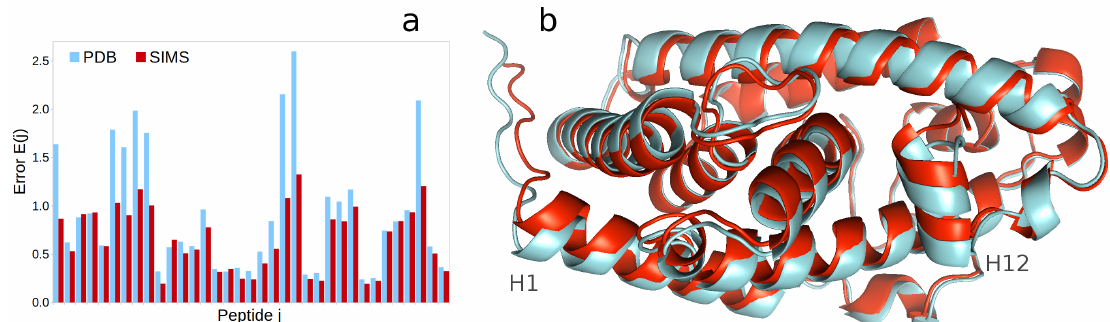
Figure 2. Revealing the conformation of the unbound form of the vitamin D receptor’s ligand-binding domain (VDR-LBD). ( a ) Differences between structurally-derived and experimental hydrogen-exchange data (unitless error E(j) , for each peptide j ) are significantly lower when these data were derived from the conformation produced by SIMS for the unbound VDR-LBD (colored red) than when they were derived from the conformation of the bound VDR-LBD reported in the PDB (colored blue). ( b ) The conformation of the unbound VDR-LBD produced by SIMS (colored red) differs from that of the bound VDR-LBD from the PDB (ID 3P8X, colored blue) mostly in the positions of α -helices H1 and